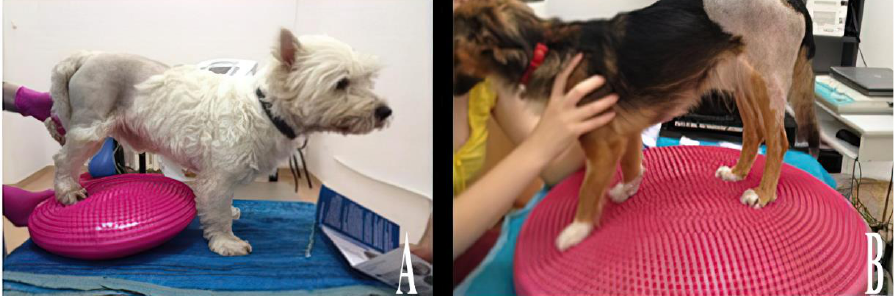
Figure 7. Exercises performed on a small mattress ( A ) and on a large mattress ( B ).